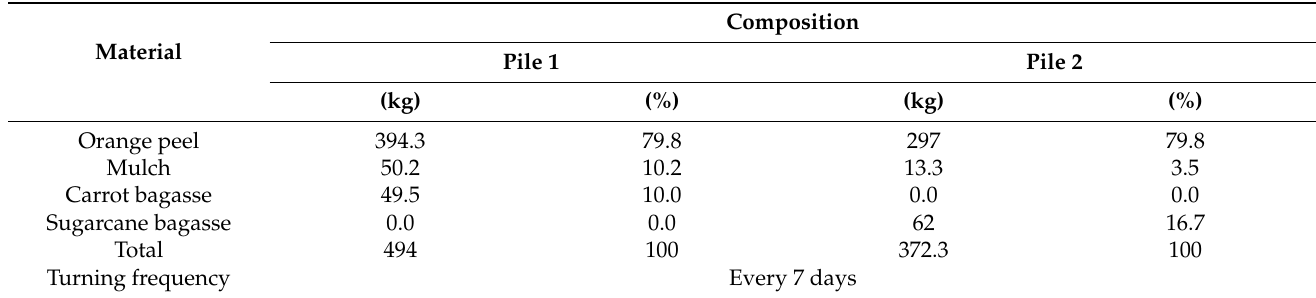
Table 1. Proportion of materials in waste piles.